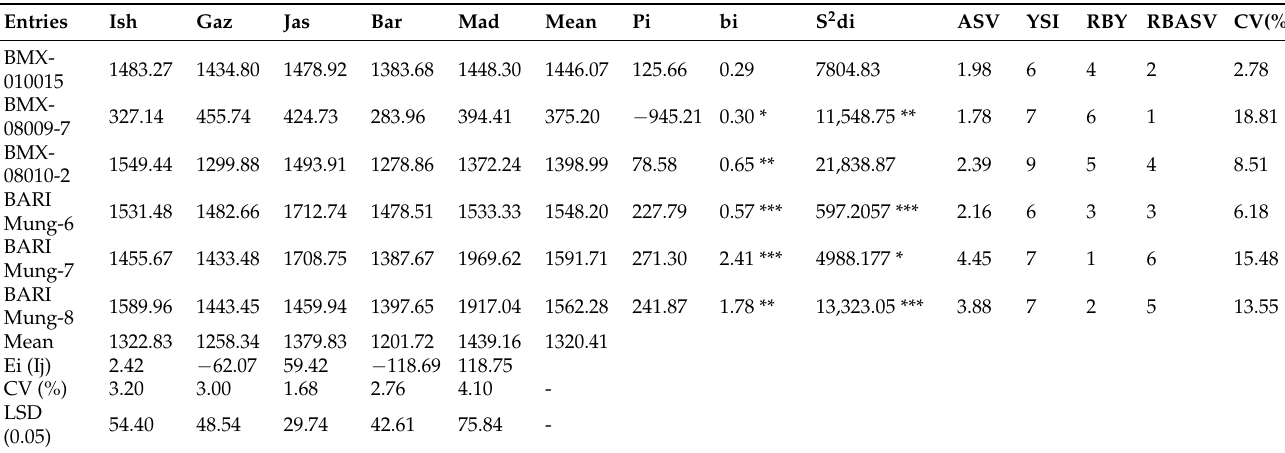
Table 9. Genotypes performance for yield stability evaluated at different environments.